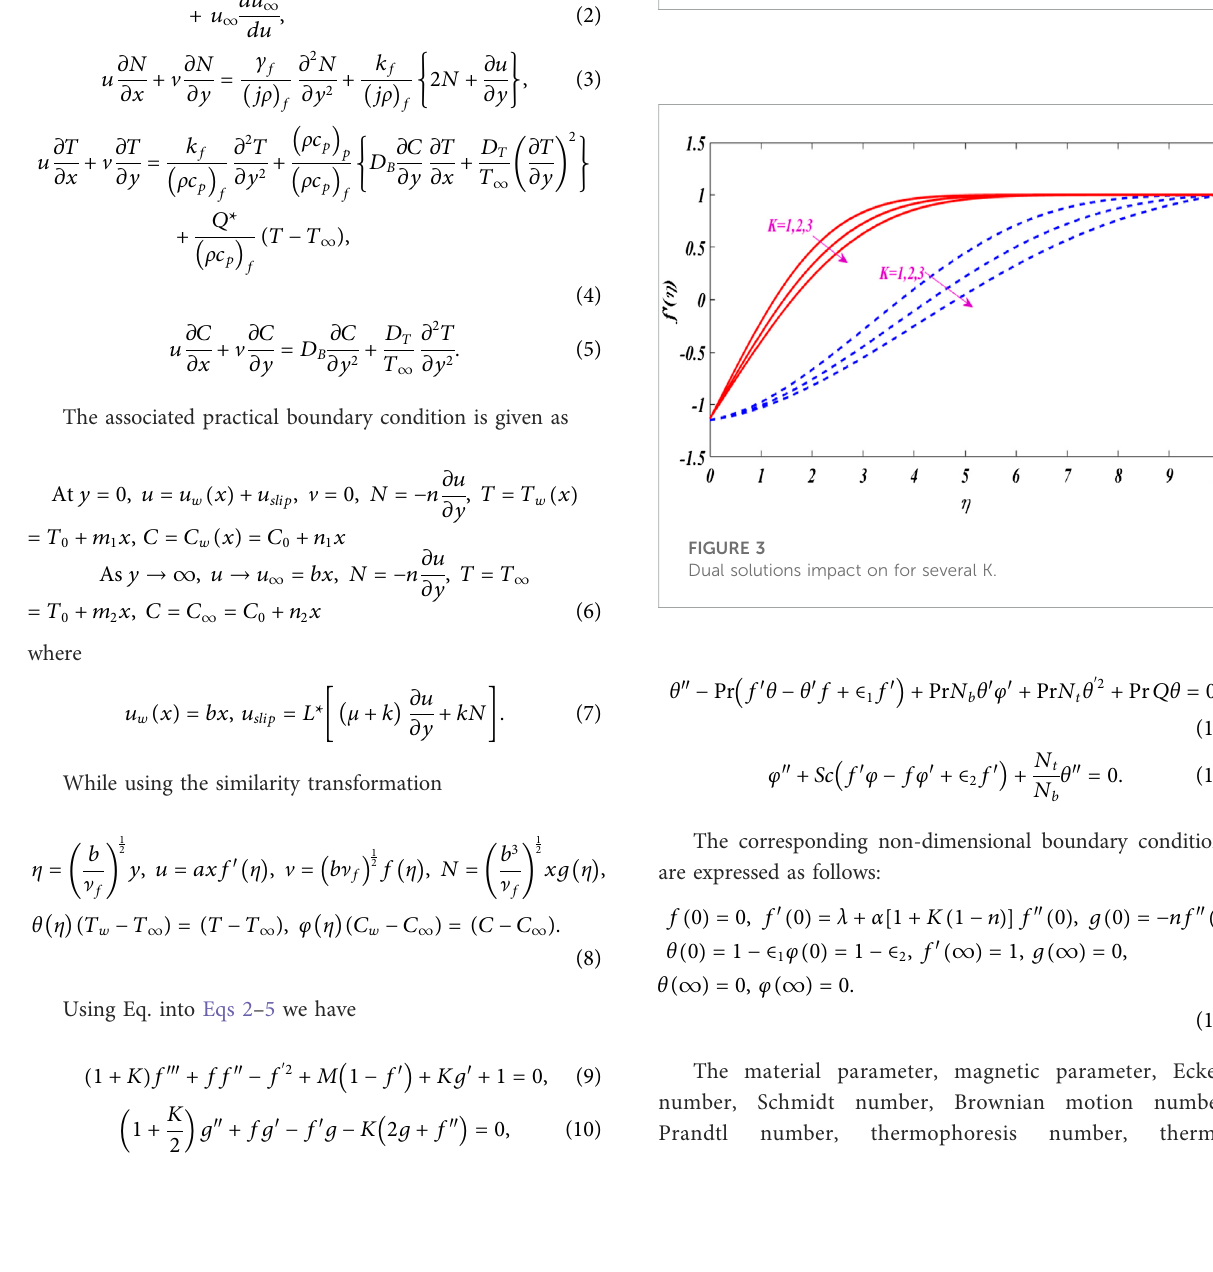
Dual solutions impact on for several M.